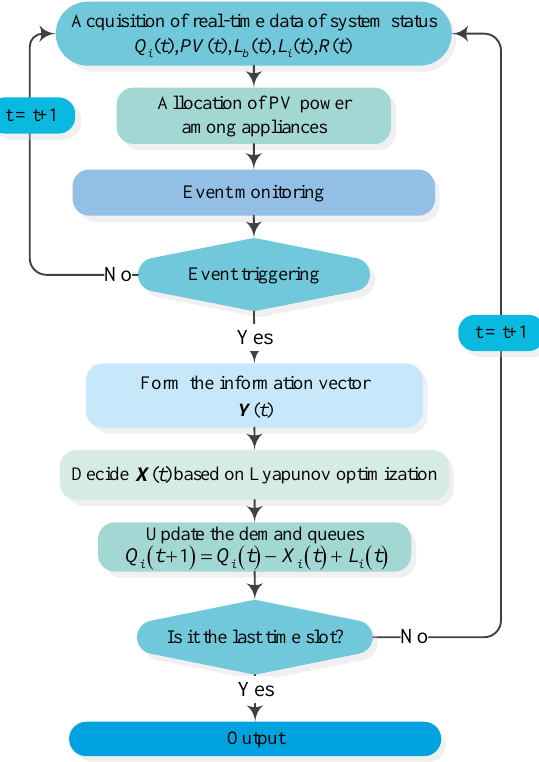
Figure 3. Flowchart of the online energy management